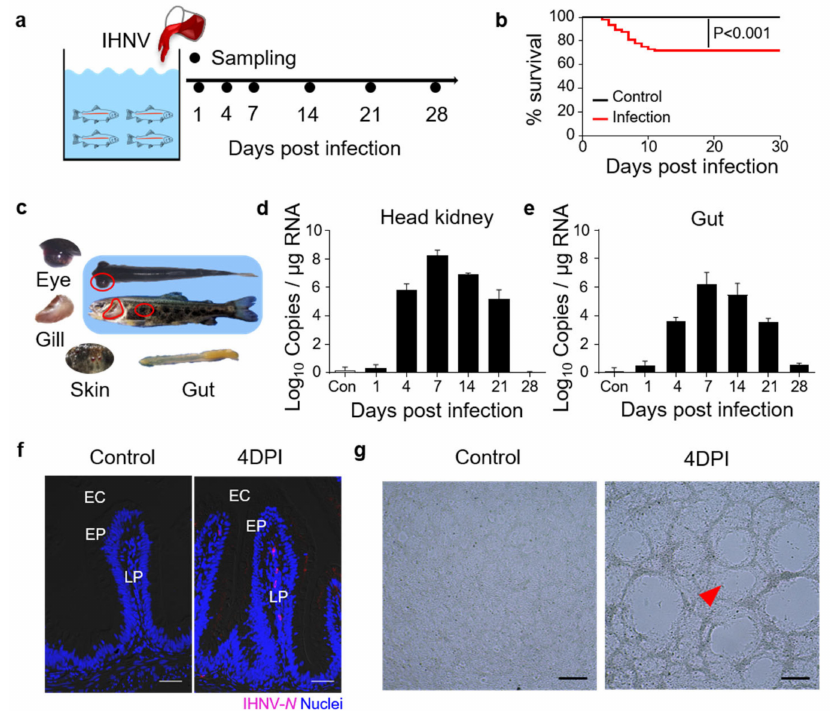
Figure 1. Construction of the model of infected with infectious hematopoietic necrosis virus (IHNV) − infected rainbow trout. ( a ) Scheme of the infection strategy with IHNV by bath. ( b ) Cumulative survival rate of control and IHNV − infected fish. ( c ) The clinical signs